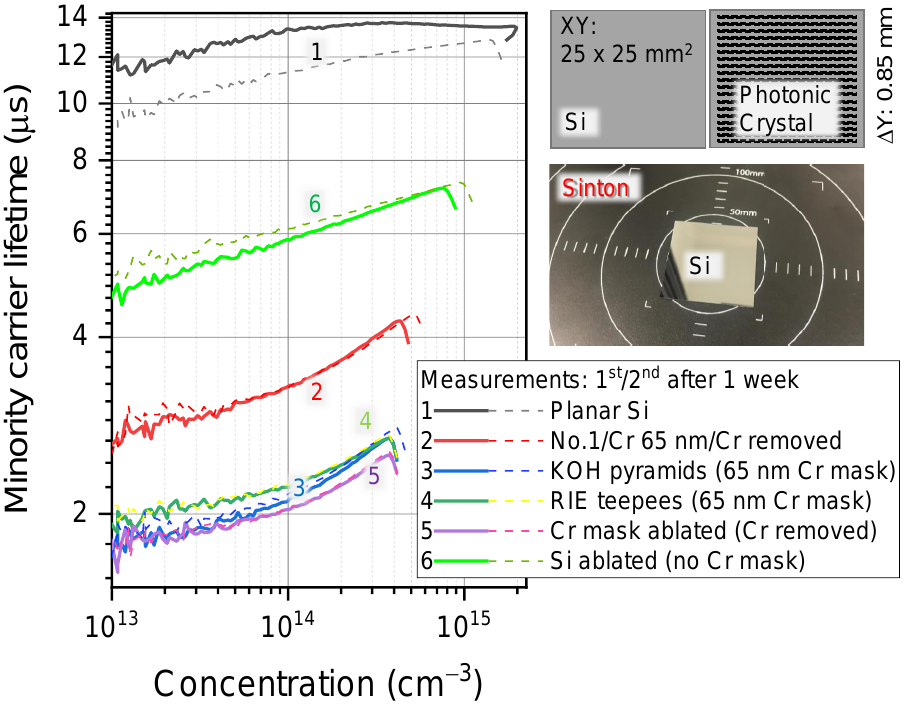
Figure 8. The lifetime of minority carriers τ mc vs. the concentration in the Si with different surface treatments measured with the Sinton (Si p-type, boron doping). The inset shows the schematics of the fabricated patterns on the 25 × 25 mm 2 area samples. Photonic crystal structures with a Λ = 3.1 µ m period were laser patterned with a ∆ y = 0.85 mm separation (an ∼ 15% coverage of the surface by PhC was performed). The quasi-steady-state (QSS) mode of calculations was carried out with optical factors f = 0.7 (non-textured, Nos. 1, 2) and f = 0.95 (textured, Nos. 3, 4, 5, 6) for the samples. The Si wafer here was 300 µ m thick, and the Cr film used for the mask was e-beam